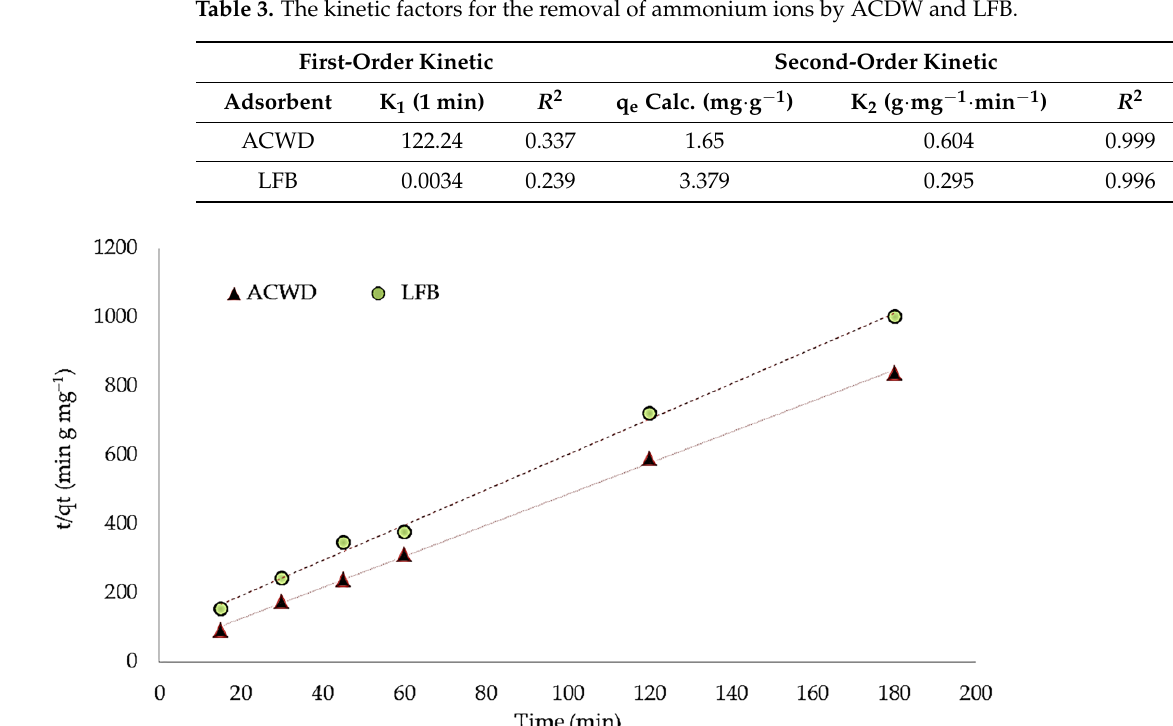
Figure 11. Pseudo-second-order kinetics of ammonium using whole biomass (ACDW) and lipid-free biomass (LFB) of Figure 11. Pseudo ‐ second ‐ order kinetics of ammonium using whole biomass (ACDW) and lipid ‐ free biomass (LFB) of Arthrospira platensis . Arthrospira platensis